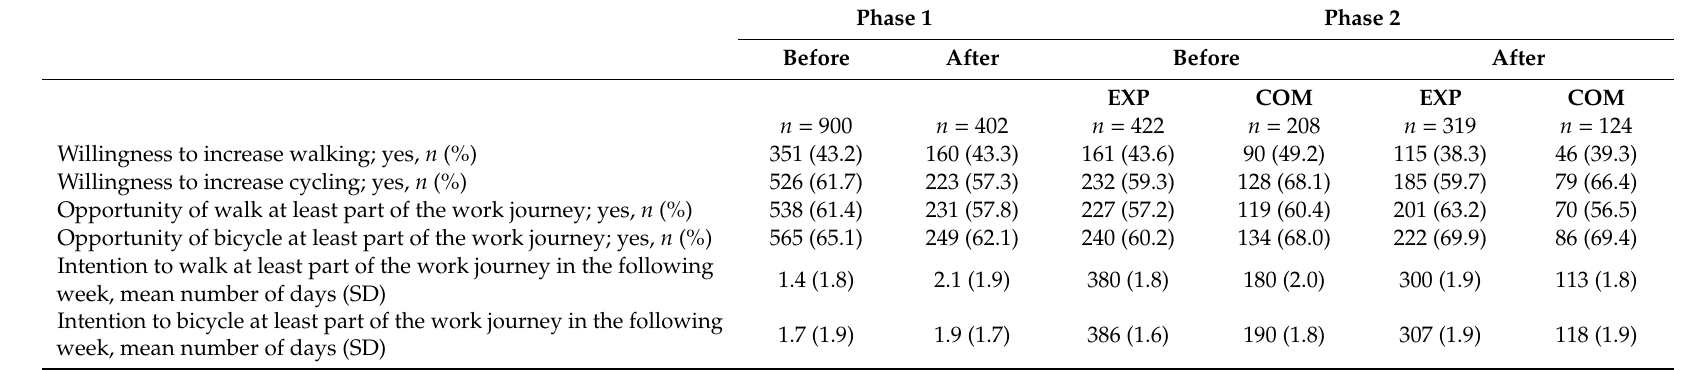
Table 3. Employees’ motivation for Active commuting to work (ACW) before and after Phase 1 and Phase 2. EXP: experimental group; COM: comparison group. Phase 1 Phase 2